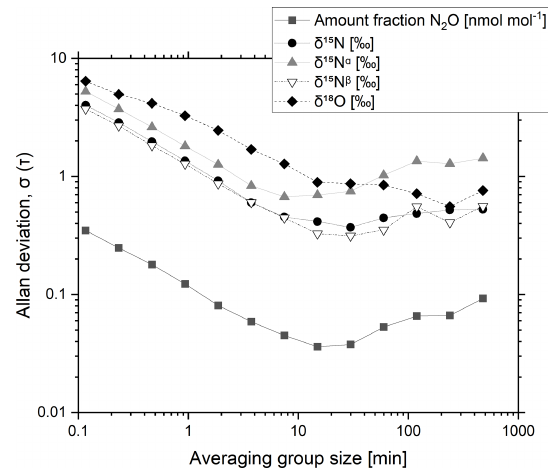
Figure 1. Typical Allan deviation plot for a CRDS N 2 O iso- tope analyser (G5131- i ) as a function of averaging time for a 325nmolmol − 1 N 2 O reference